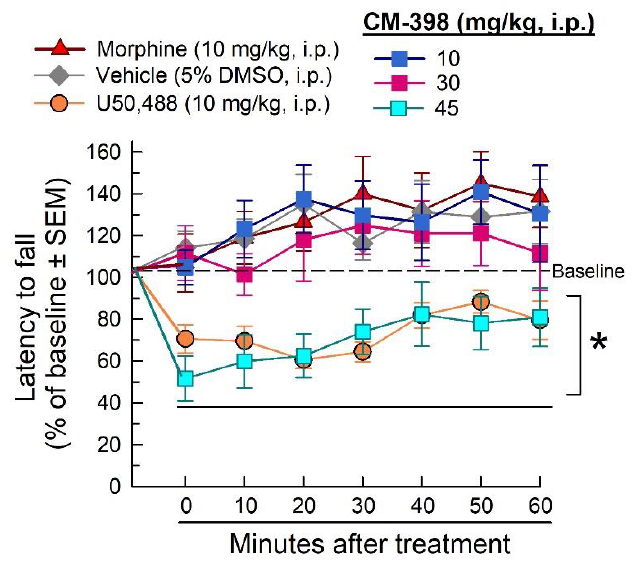
Figure 6. Assessment of CM-398 for dose- and time-dependent changes in evoked locomotor activity in the mouse rotarod assay. CM-398 (squares) was administered at 10, 30, or 45 mg/kg, i.p. doses prior to testing. U50,488 (10 mg/kg, i.p; orange circles) served as a positive control; * = significantly different from vehicle response (5% DMSO, i.p.; gray diamonds), p < 0.05; two-way ANOVA with Dunnett’s post hoc test; n = 8–12 mice/treatment.